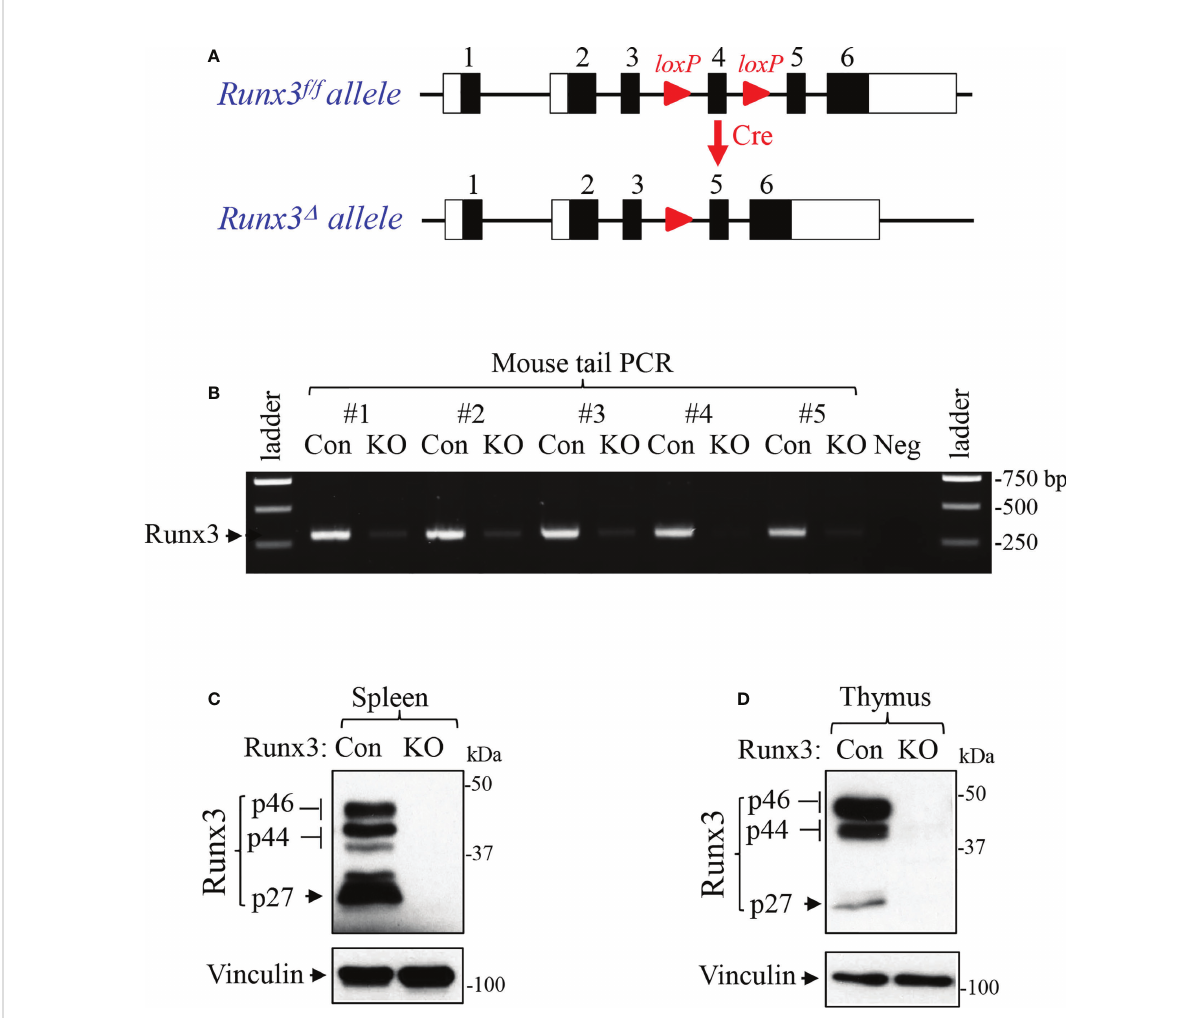
FIGURE 1 Generation and veri fi cation of an inducible Runx3 general KO mouse model. (A) Schematic illustration of the Runx3 f/f and conditional Runx3 KO alleles. (B) Veri fi cation of Runx3 deletion by mouse tail PCR in 5 paired sex- and age-matched littermate control (Con) and Runx3 KO mice two weeks after tamoxifen treatment. Neg: negative control. (C, D) Veri fi cation of Runx3 KO by Western blot analysis in spleen (C) and thymus (D) from uninfected control (Con) and Runx3 KO mice two weeks after tamoxifen treatment. Equal amounts of cell lysates were subjected to Western blotting with Runx3 antibody. Results are representative of the fi ndings of three independent